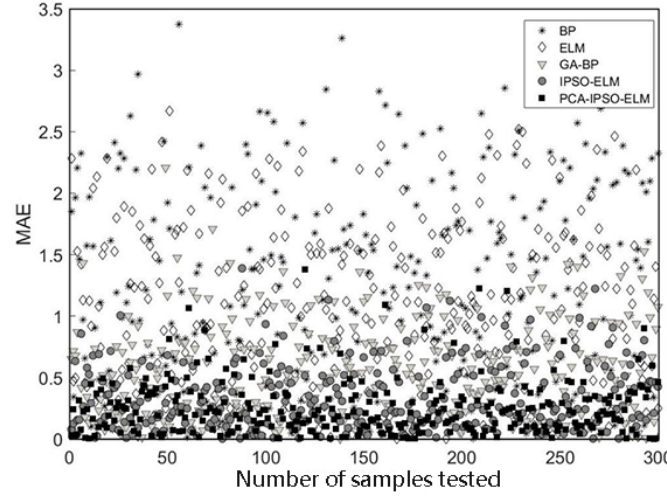
Figure 8. Comparison chart of absolute error of algorithm